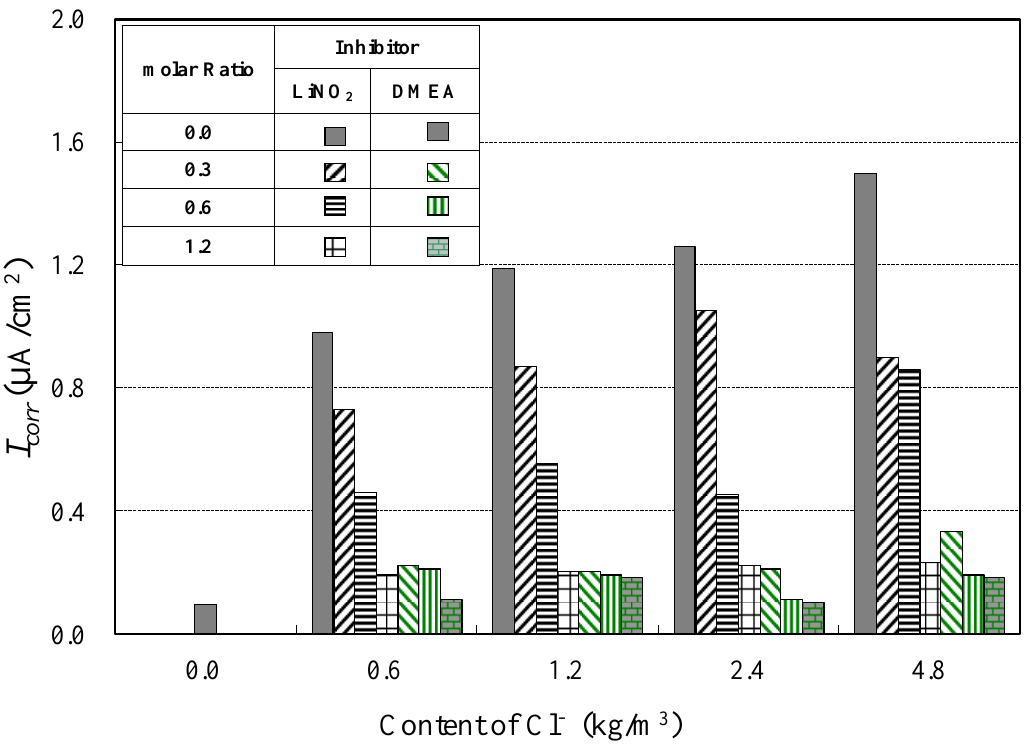
Figure 7. Corrosion current density of the different